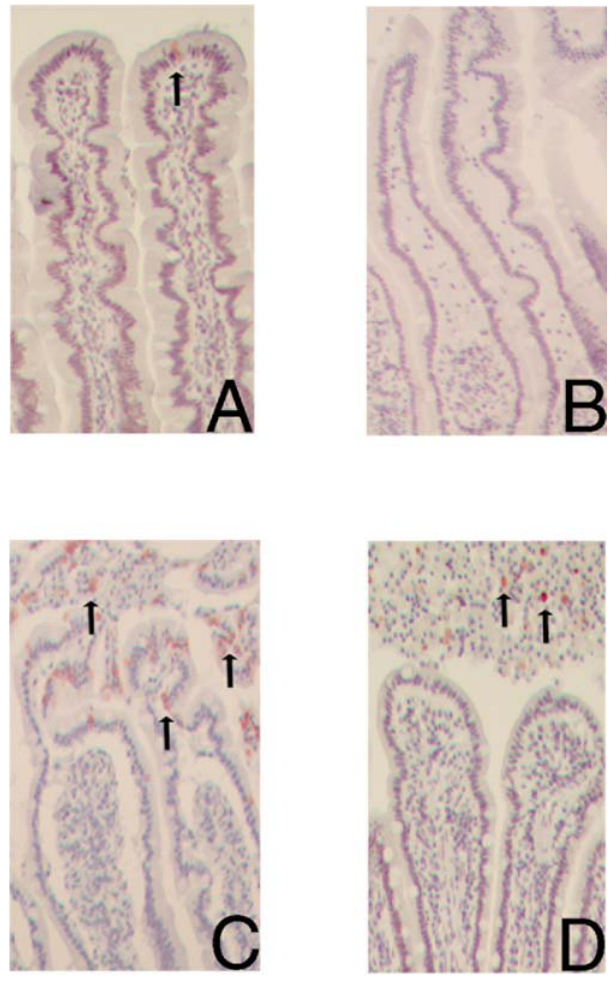
Figure 5. Apoptosis, assessed by M30 staining in red (AEC). An M30 positive cell (arrow) is observed at the top of the villus in normal jejunum (100 6 ) (A). Upon 30 minutes ischemia, no M30 positive staining is found (B), while after 25 minutes reperfusion intense M30 immunostaining is observed at the villus tip near the shedding of mature epithelial cells into the lumen (arrows) (C). At 60 minutes reperfusion M30 immunoreactivity is no longer detectable in the intact, resealed epithelial barrier, while debris of M30 positive, shedded epithelial cells is observed in the lumen (D).